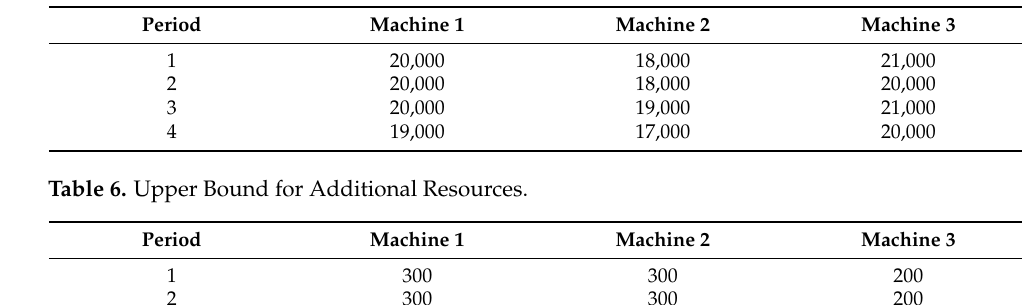
Table 5. Capacity of Resource available.